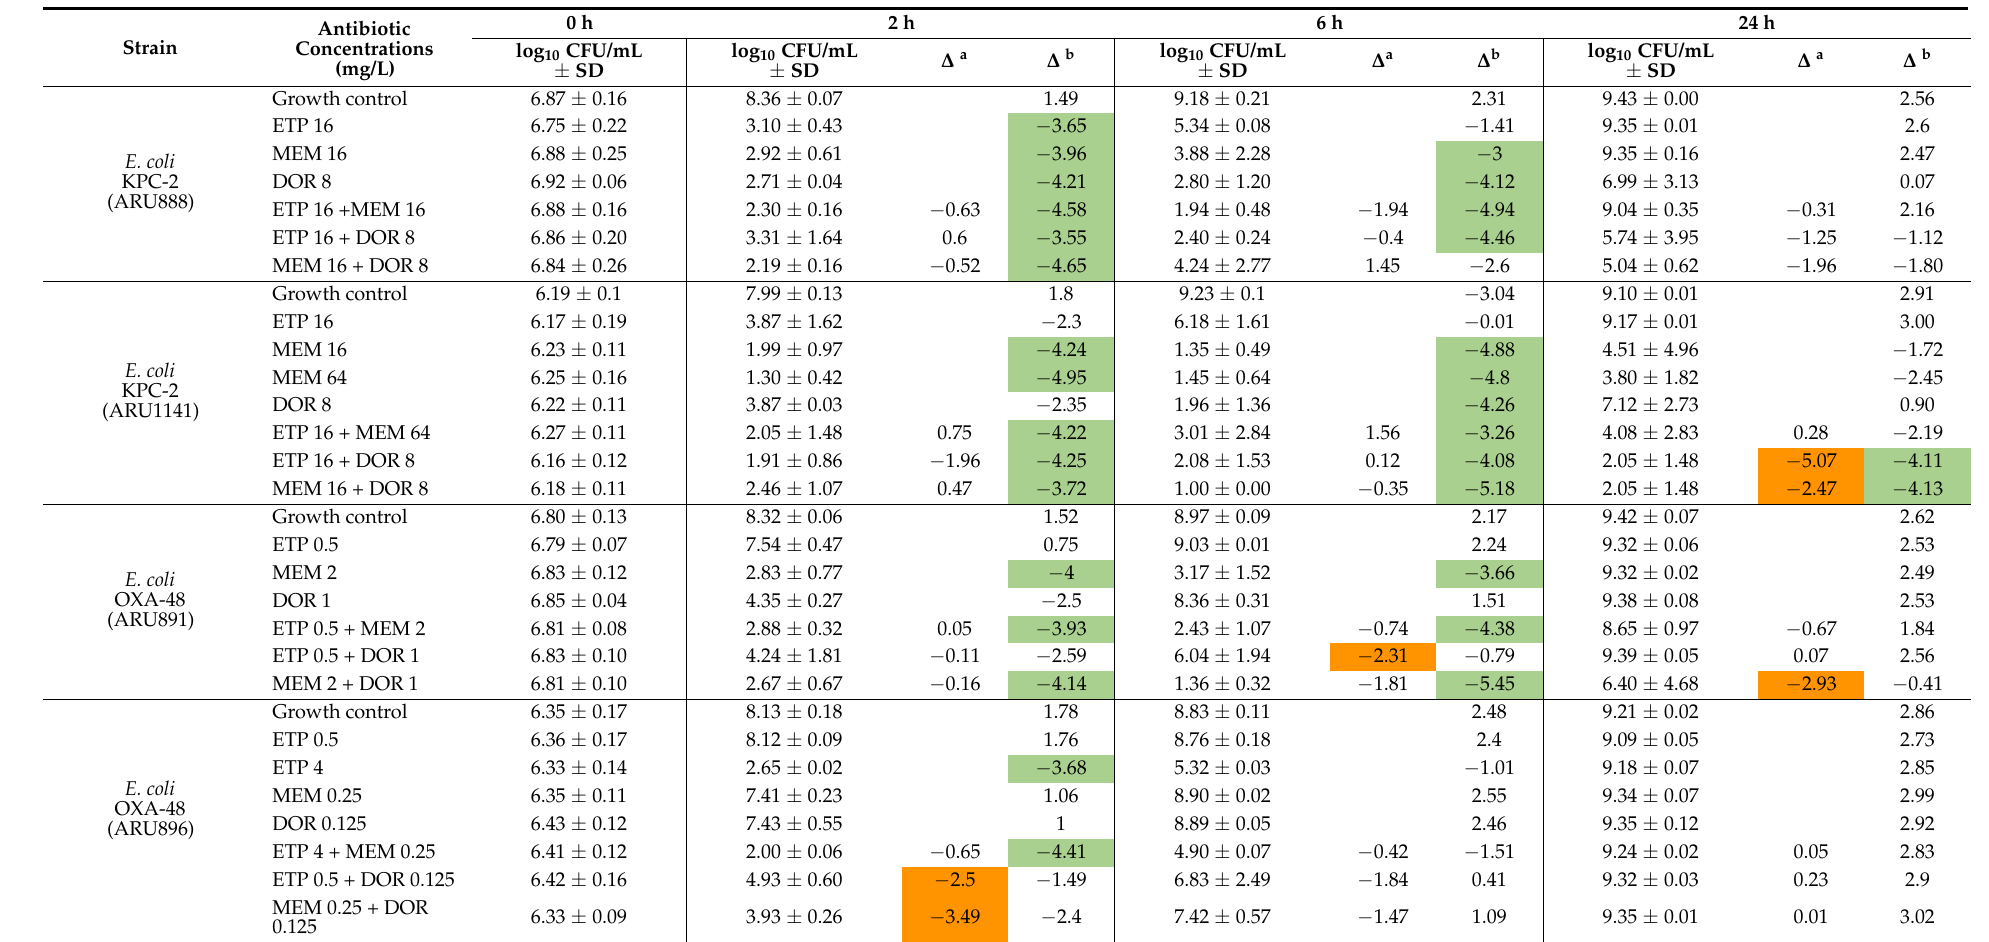
Table 4. Mean bacterial concentrations (log 10 CFU/mL) at 0, 2, 6, and 24 h during time-kill experiments with ertapenem, meropenem, and doripenem, alone and in two-drug combinations against clinical carbapenemase-producing isolates. The standard deviation (SD) at each time point is shown. Synergy ( ≥ 2 log 10 reduction in CFU/mL compared to the most effective single antibiotic) is highlighted in orange. Bactericidal effects ( ≥ 3 log 10 reduction in CFU/mL compared to the starting inoculum) are highlighted in